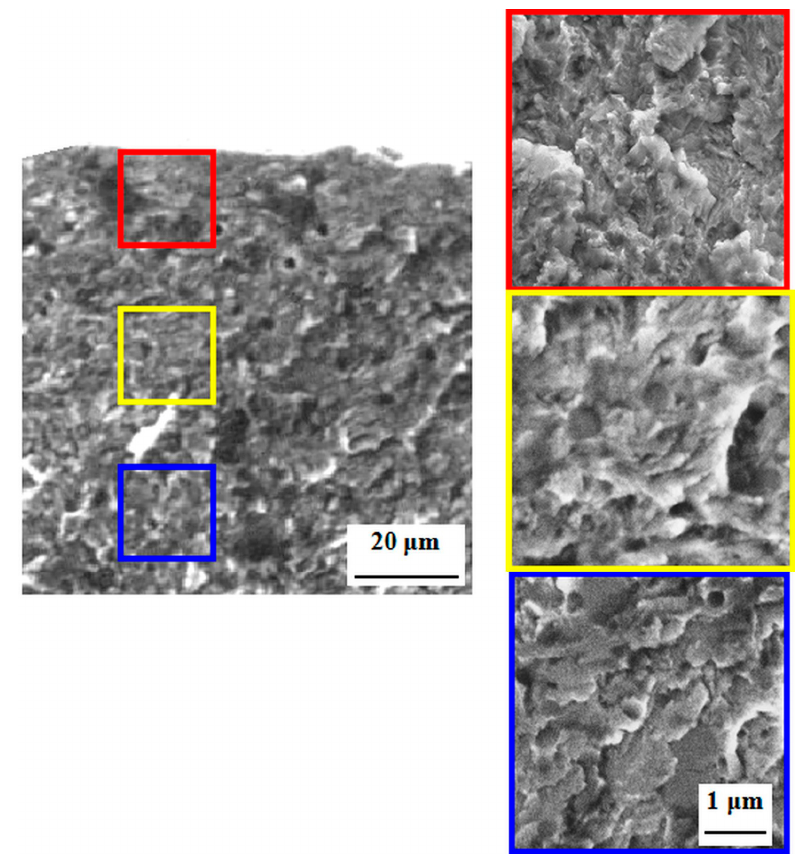
Figure 12. SEM micrographs showing fracture surface of specimen made of Vanadis 6 steel nitrided at 530 °C for 120 min.